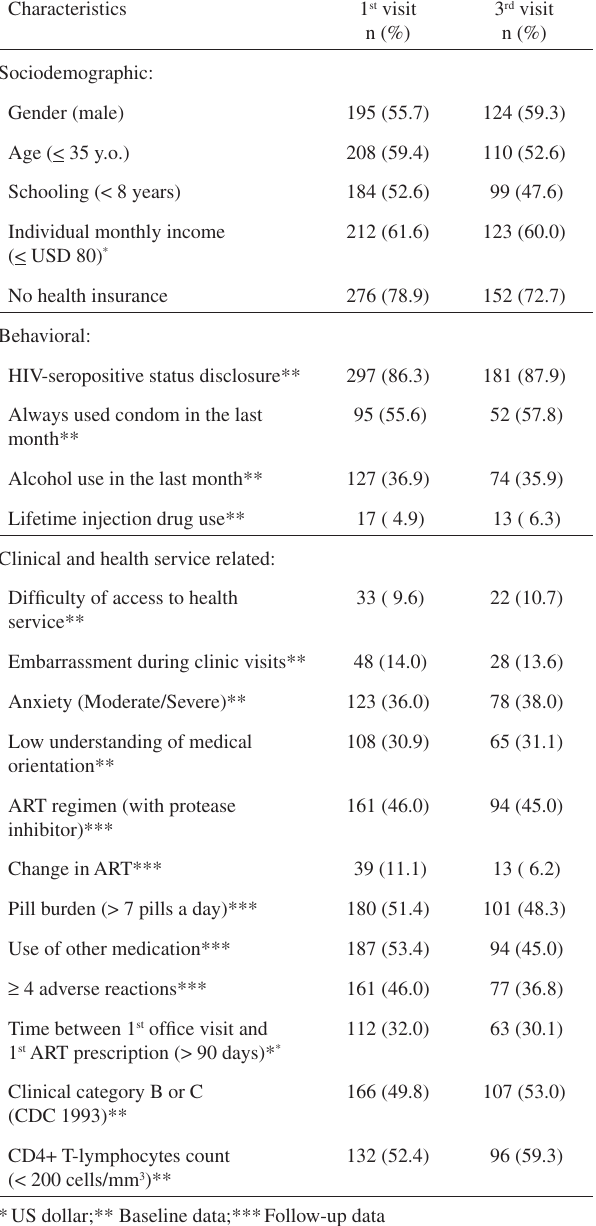
Table 1 - Descriptive characteristics of participants in the first (n=350) and third (n=209) follow-up visits, ATAR Project,